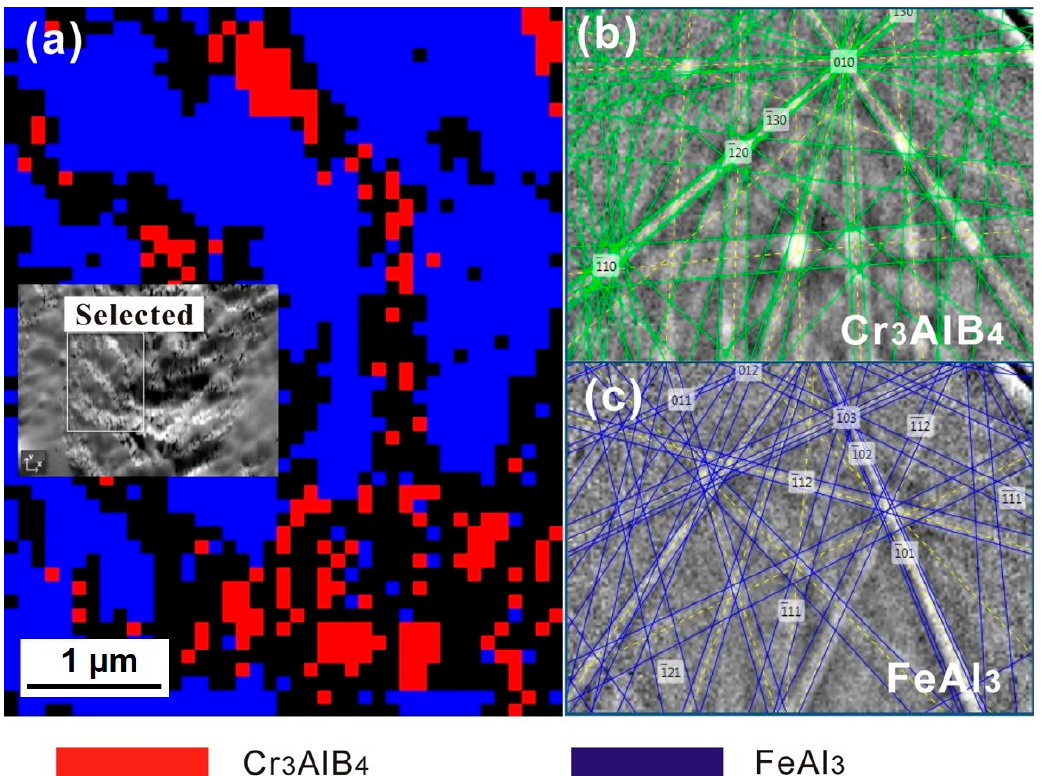
Figure 7. EBSD mappings of the phase distribution in the corrosion layer: ( a ) phase distribution map. ( b ) and ( c ) Kikuchi patterns from individual phases.